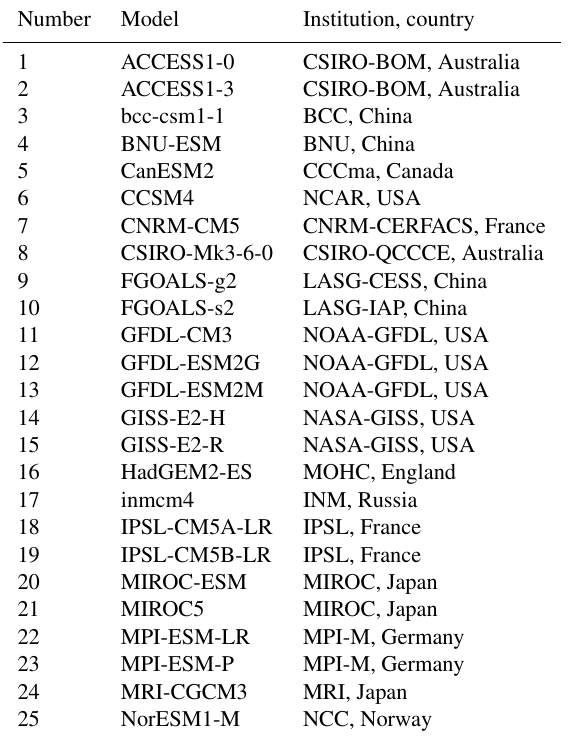
Table 2. Models belonging to the CMIP5 ensemble used in this